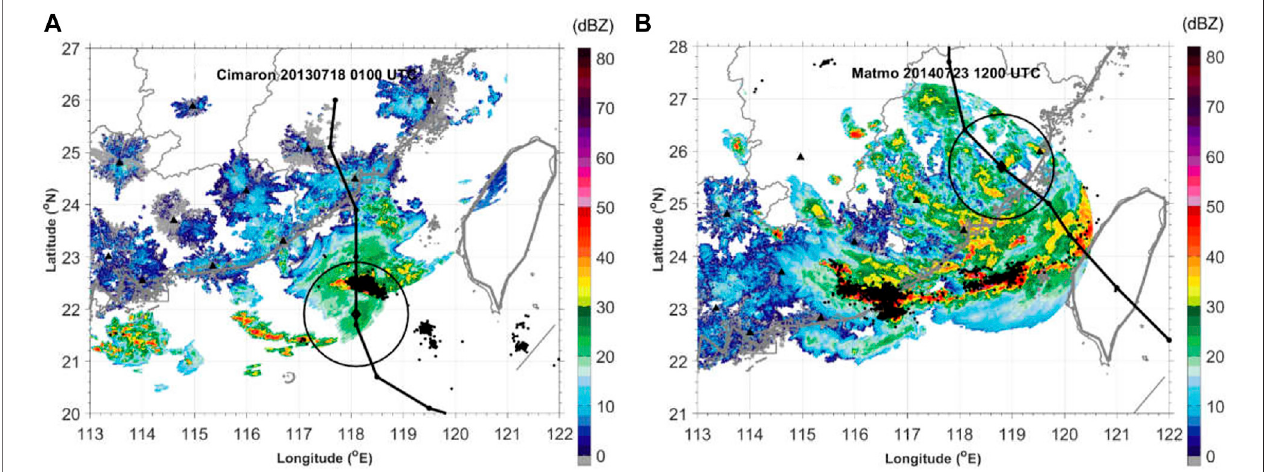
FIGURE 2 | Overlay of lightning activity and radar composite re fl ectivity at the hours producing the maximum lightning rates in (A) the inner core for Tropical Storm Cimaron (2013) and (B) the outer rainbands for Severe Typhoon Matmo (2014). The black dots denote WWLLN strokes. The black triangles represent the costal radar stations. The black circle indicates the 100-km radius from the storm